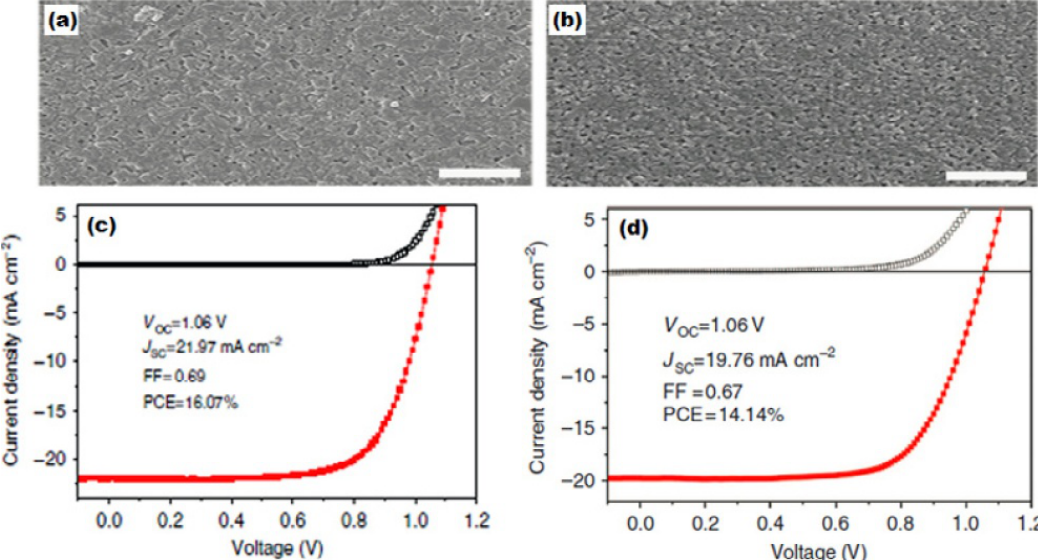
Fig. 10. Performance comparison of ETL free device: (a) Top-view SEM images of the CH with UVO treatment (b) without UVO treatment (c) J-V curve of device with ETL (FTO/TiO Spiro-OMeTAD/Au) and (d) without ETL (FTO/CH